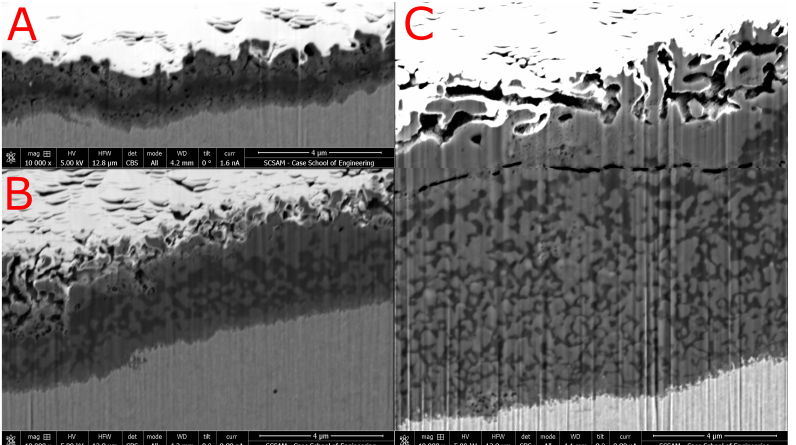
Figure 5. SEM images of FIB-cuts showing the activated surface of AISI-316L samples TX , activated with 15 N 2 H 4 Cl at 563K. ( A ) Activated for 0.3ks. ( B ) Activated for 0.9ks. ( C ) Activated for